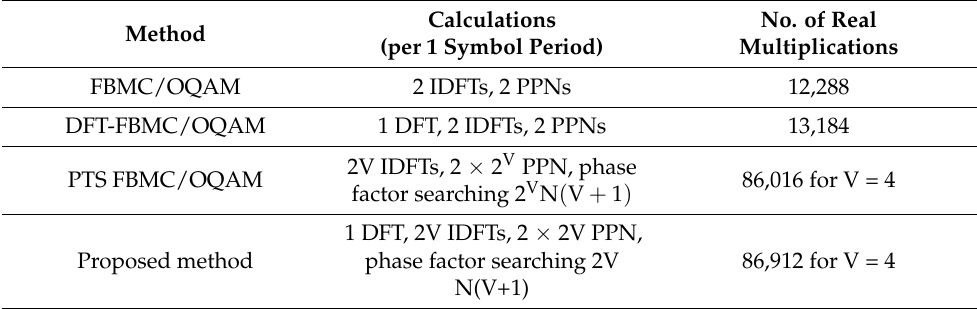
Table 3. Simulation parameters for computation